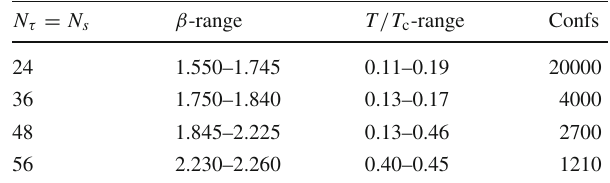
Table 7 Summary of the simulations used at zero temperature. The interval used to span the β interval is always (cid:13)β = 0 . 005. The range in T / T c is the “residual” non-zero temperature of the system determined from Fig. 1